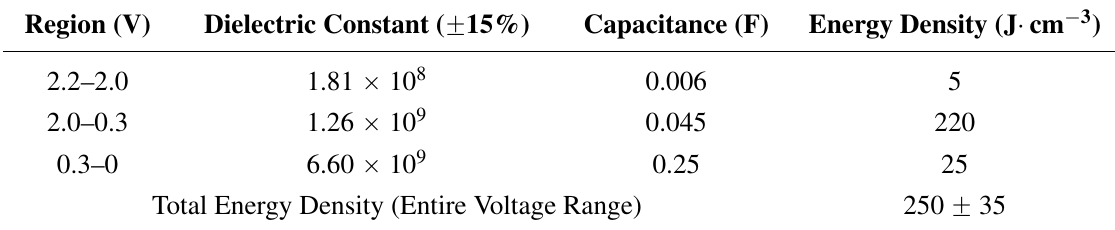
Table 1. Capacitive energy storage. Average values of dielectric constant, capacitance and energy density for the four cycles shown in Figure 1, left side. The values recorded for each individual cycle were within 15% of the average values reported. Indeed, the highest measured energy density was 280 J ¨ cm ´ 3 and the lowest 225 J ¨ cm ´ 3